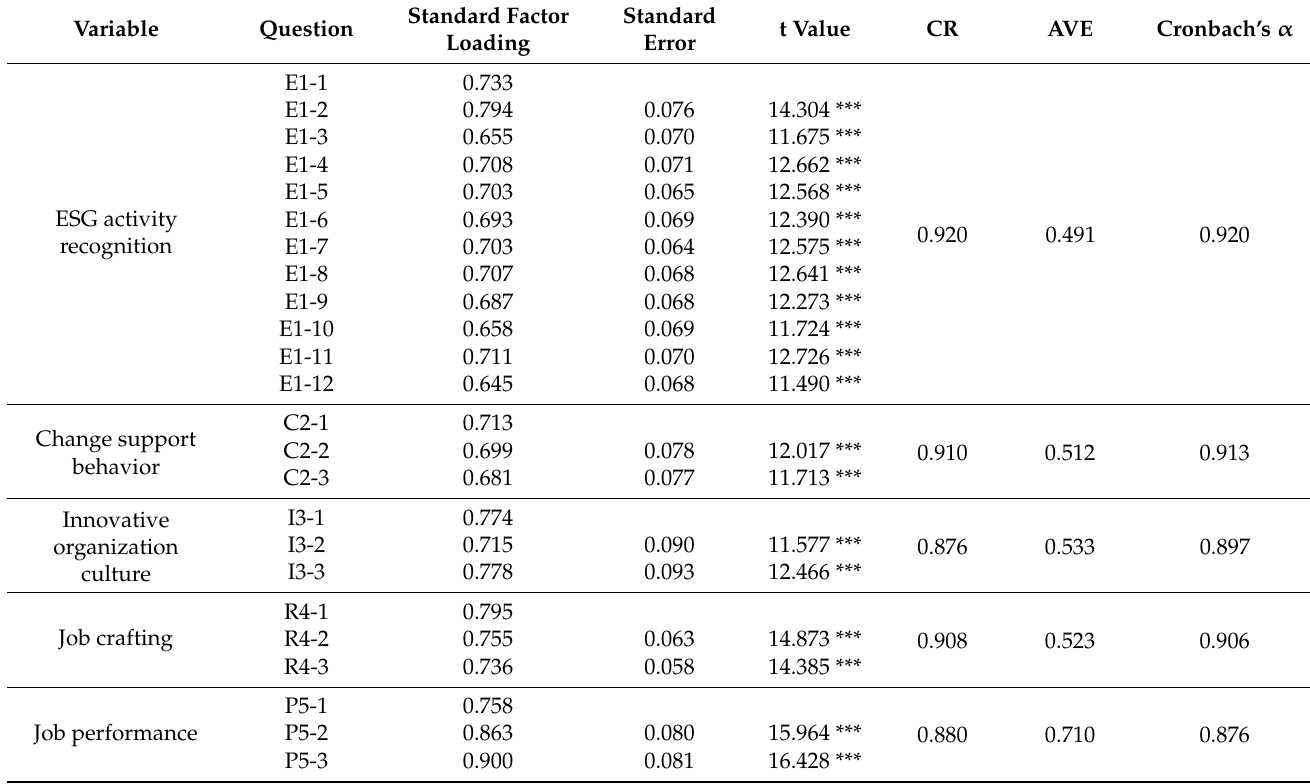
Table 4. Results of reliability and convergent validity tests.